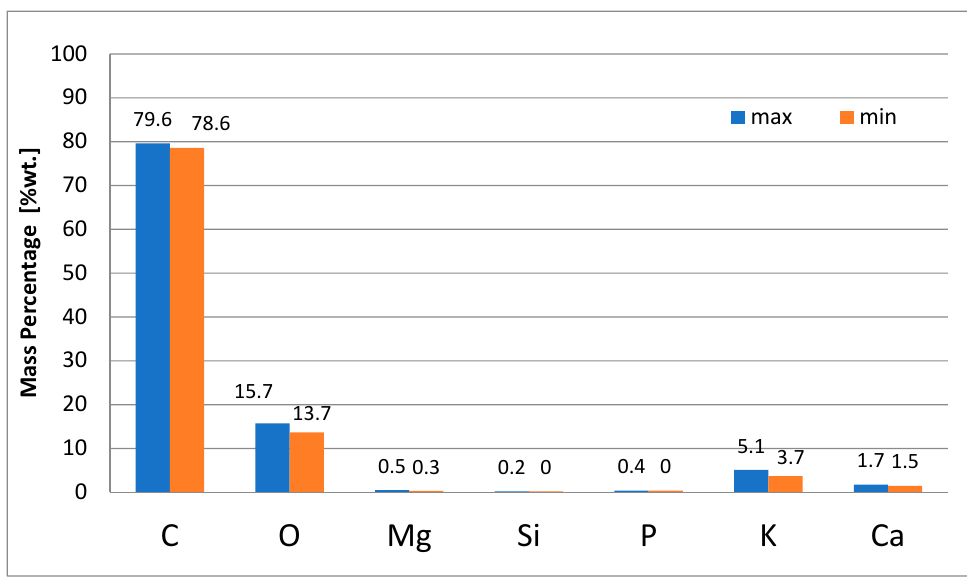
Figure 4. EDS analyses of cleaned and milled biochar pellets, and mass percentages of the detected elements. Maximum and minimum values obtained on three repeated spectra on the same sample are shown.